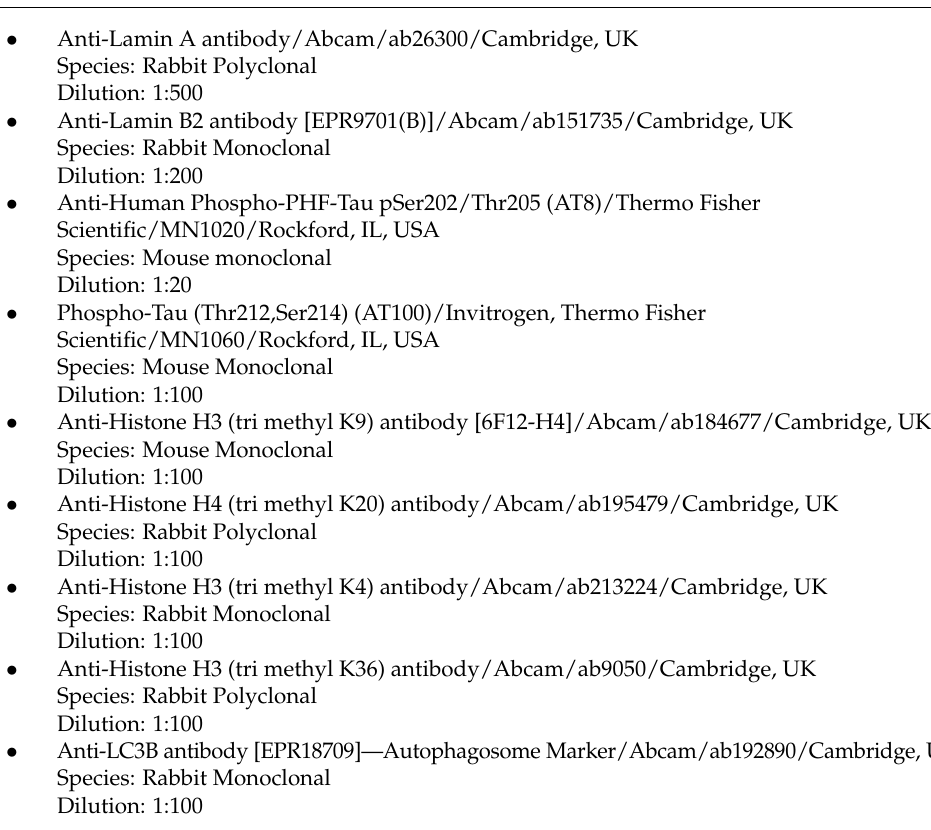
Table 1. List of employed